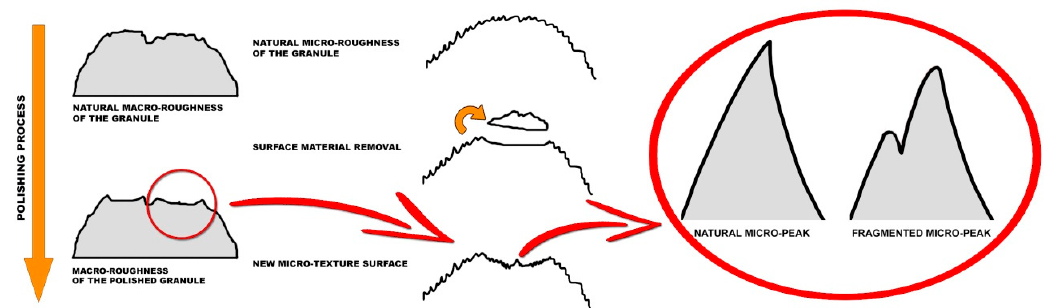
Figure8. Schematizationoffragmentationphenomenonoftheaggregatesurfacesunderpolishingprocedure. Appl. Sci. 2019 , 9 , x FOR PEER REVIEW 10 of 14 Figure 8. Schematization of fragmentation phenomenon of the aggregate surfaces under polishing procedure.